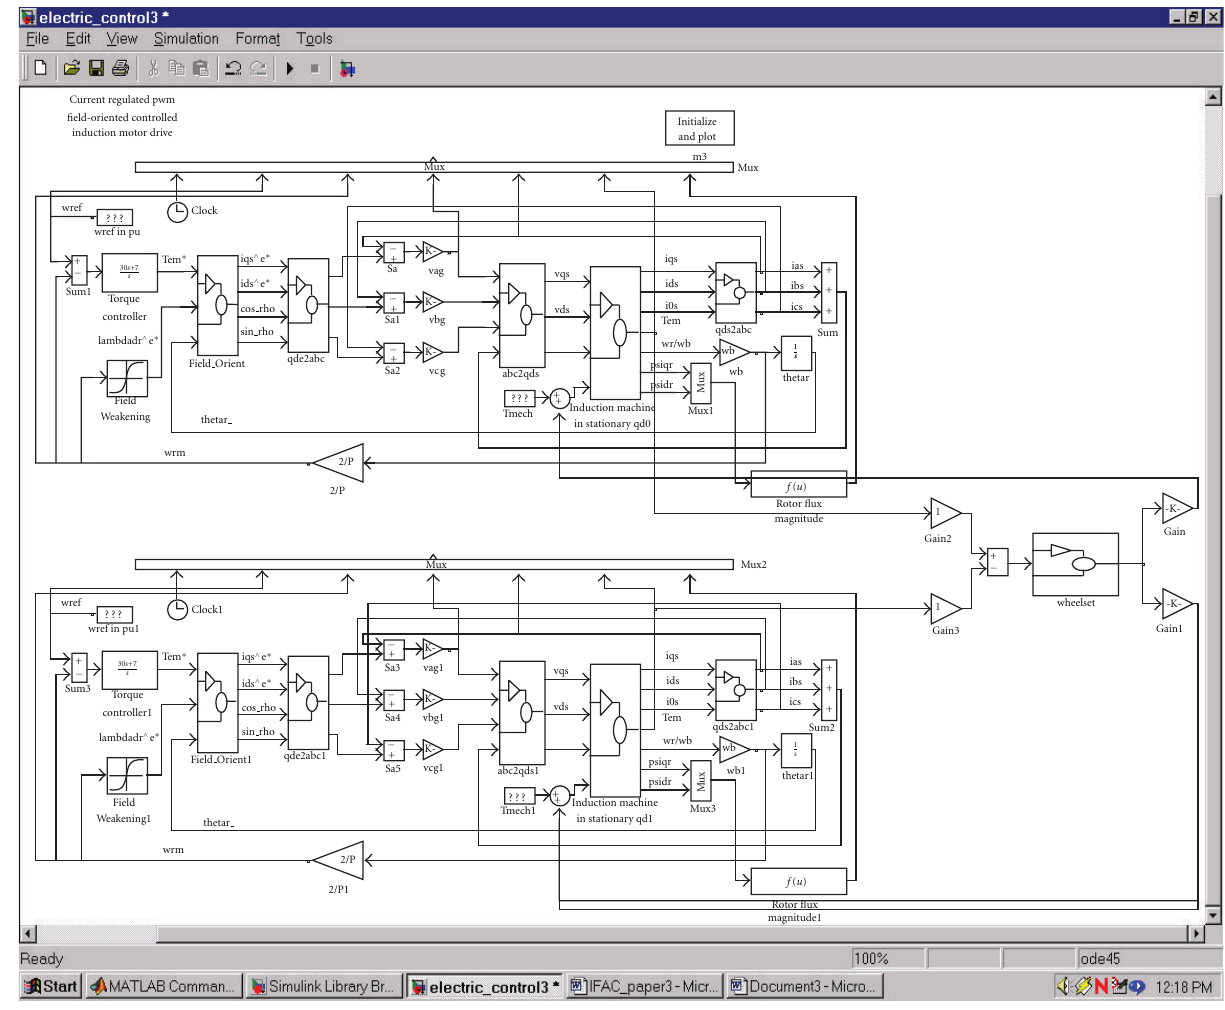
Figure 3: The simulink block diagram of the whole system.